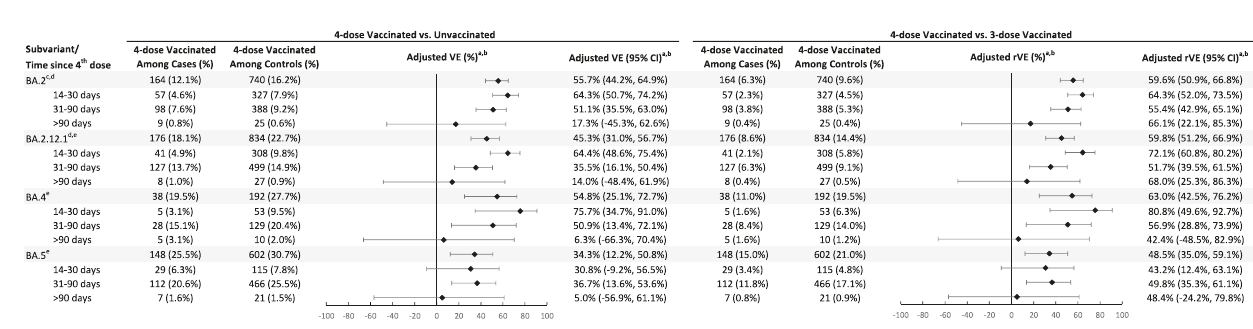
month of specimen collection, history of SARS-CoV-2 infection, history of SARS- CoV-2 molecular test, number of outpatient and virtual visits, medical center area, and time between third dose and specimen collection date (for four-dose versus three-dose models only). c BA.2 excluding BA.2.12.1. d Medical center area removed from adjustment set in four-dose versus three-dose models due to lack of model convergence. e Medical center area removed from adjustment set in four-dose versus unvaccinated models due to lack of model convergence. CI con fi dence